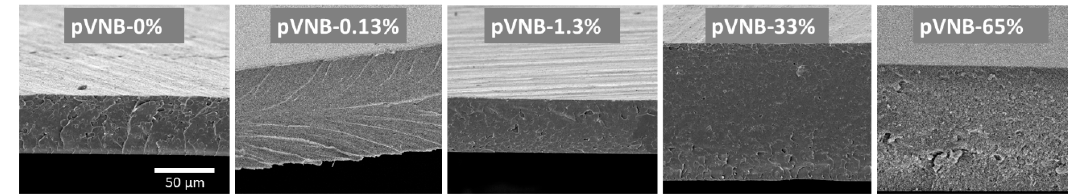
Figure 10. SEM pictures of the cross-sections of the polynorbornene membranes.